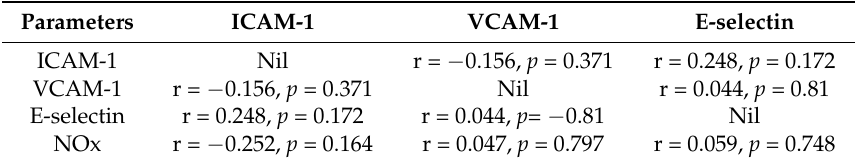
Table 2. Correlation between levels of nitric oxide metabolites (NOx) and the levels of soluble adhesion molecules in